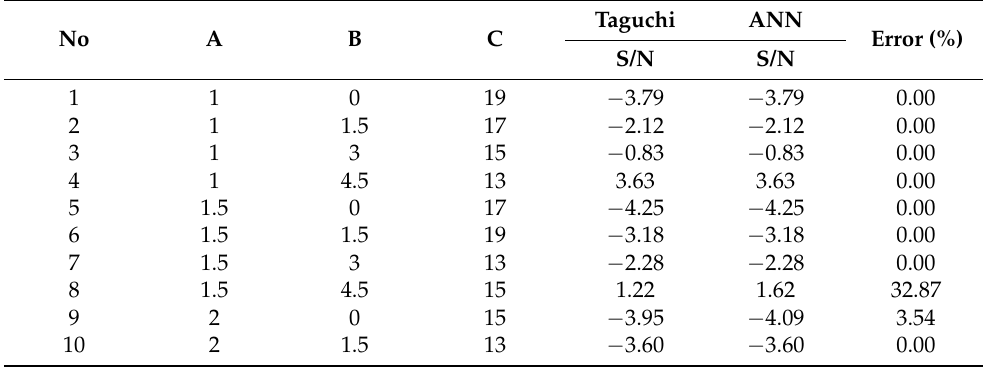
Table 6. Comparison of S/N ratio between Taguchi and ANN .